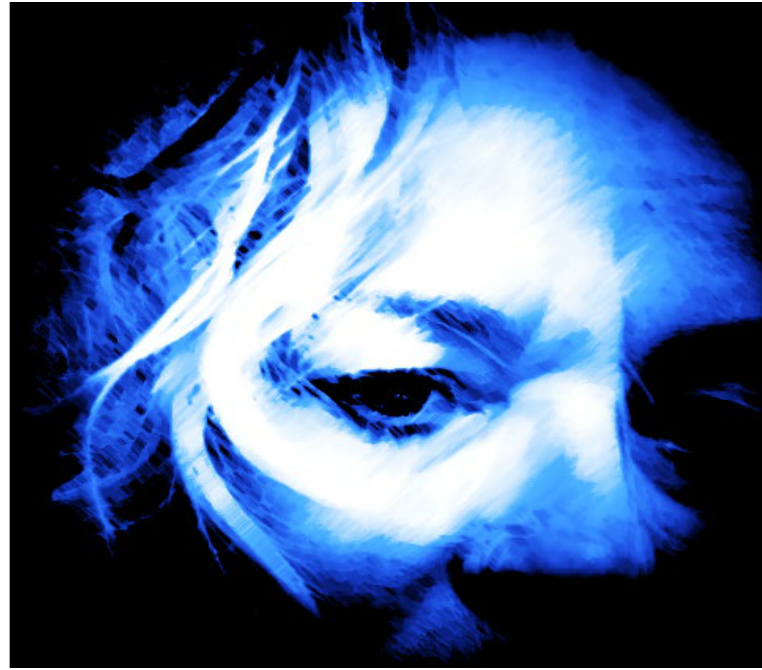
Figure 8. Lost Voices Live in